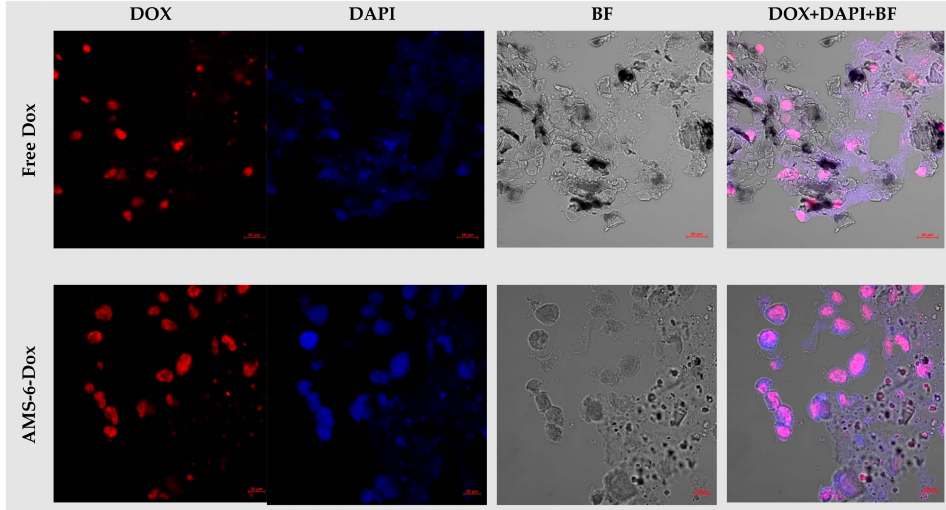
Figure A23. Laser-scanning confocal fluorescence microscopy images in 3D TECs, combining CE LS-ECM and human MDA-MB- 231 cells that were incubated with free Dox and AMS-6-Dox nanoparticles for 24 h. Intrinsic Dox fluorescence was detected in the red channel (Dox), while DAPI fluorescence (blue channel, DAPI) was used for contrasting of cell nuclei. Control bright field (BF) images were acquired to visualize the tissue structures, and merged images highlight the colocalization of Dox and DAPI signals. Note the absence of preserved cell nuclei in the depth of TEC treated with AMS-6-Dox nanoparticles (the bottom row), in comparison with TECs treated with free Dox (upper row). Dox concentration, 10 µ g/mL. Scale bars, 20 µ m (upper row) and 10 µ m (bottom row). The illumination conditions were kept constant for every imaging